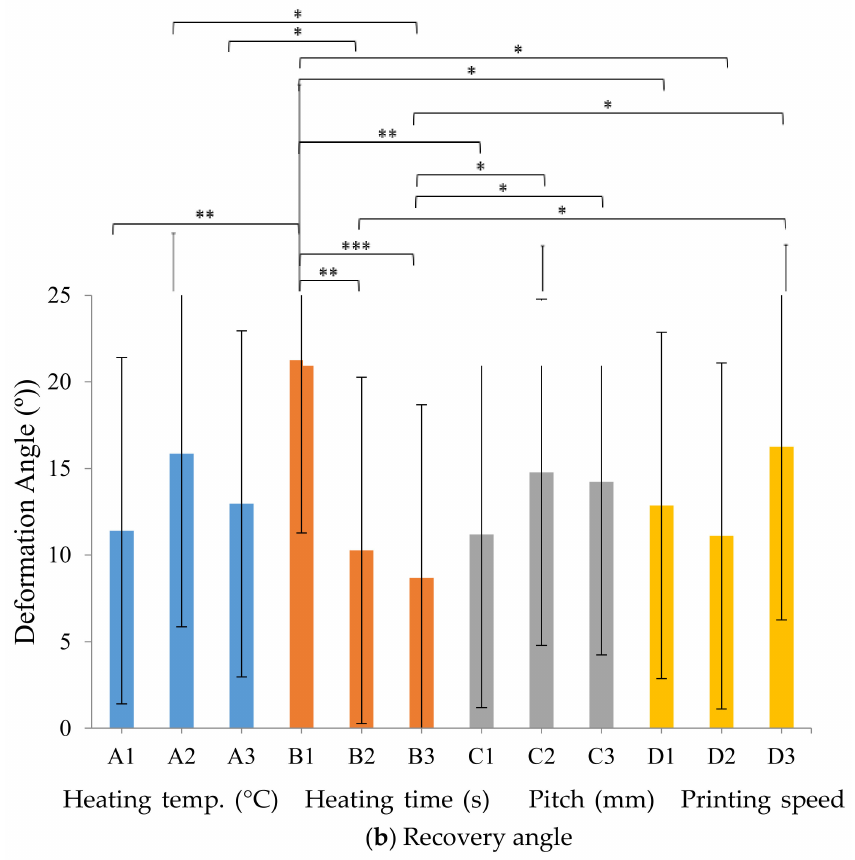
Figure 11. Deformation angle and recovery angle of the stimulus-responsive composite material with various process parameters (values are the mean ± SD of six experiments ( n = 6), * p < 0.05, ** p < 0.01, *** p < 0.001).